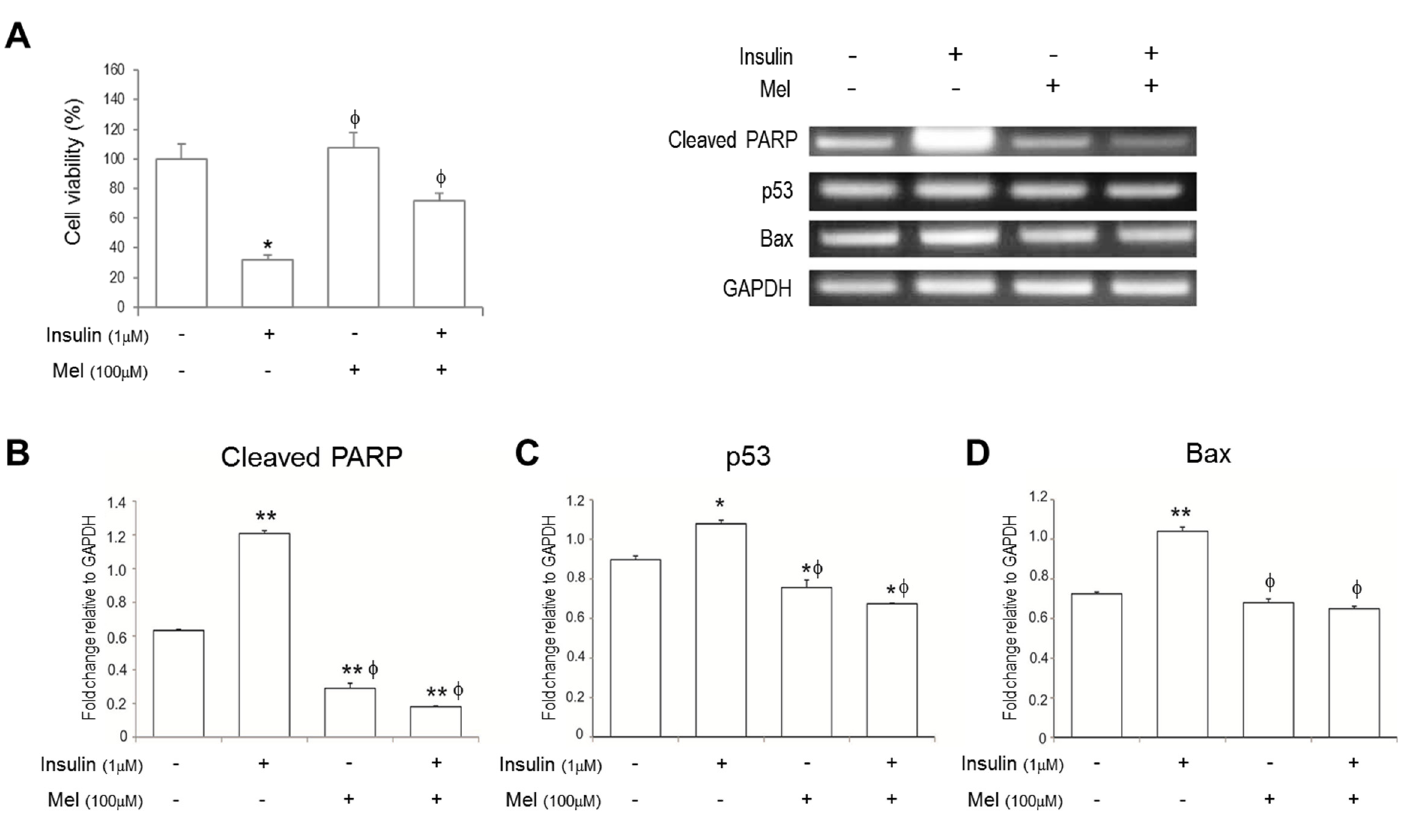
Figure 1. Melatonin alleviates insulin resistance (IR)-induced SH-SY5Y neuronal cell death signaling. ( A ) Cell viability was assessed by 3-(4,5-dimethylthiazol-2-yl)-2, 5-diphenyltetrazolium bromide (MTT) assay. The mRNA levels of ( B ) cleaved PARP; ( C ) p53; and ( D ) Bax were measured by reverse transcription PCR. Data are expressed as mean ± standard error and each experiment included three repeats per conditions. * p < 0.05, ** p < 0.01 compared with non-stimulated control; φ p < 0.05 compared with insulin stimulated cells. Mel: melatonin pretreatment for 24 h before insulin stimulation.